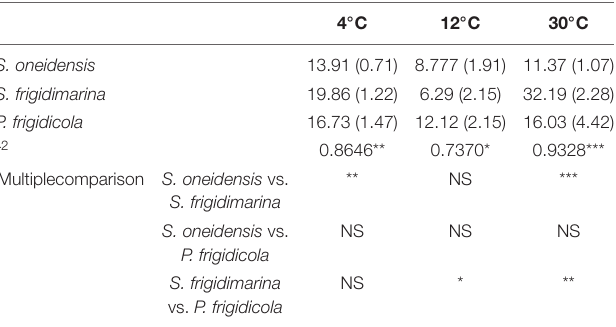
TABLE 4 | Growth rates (h − 1 ) of S. oneidensis , S. frigidimarina , and P. frigidicola at 4, 12, and 30 ◦ C.